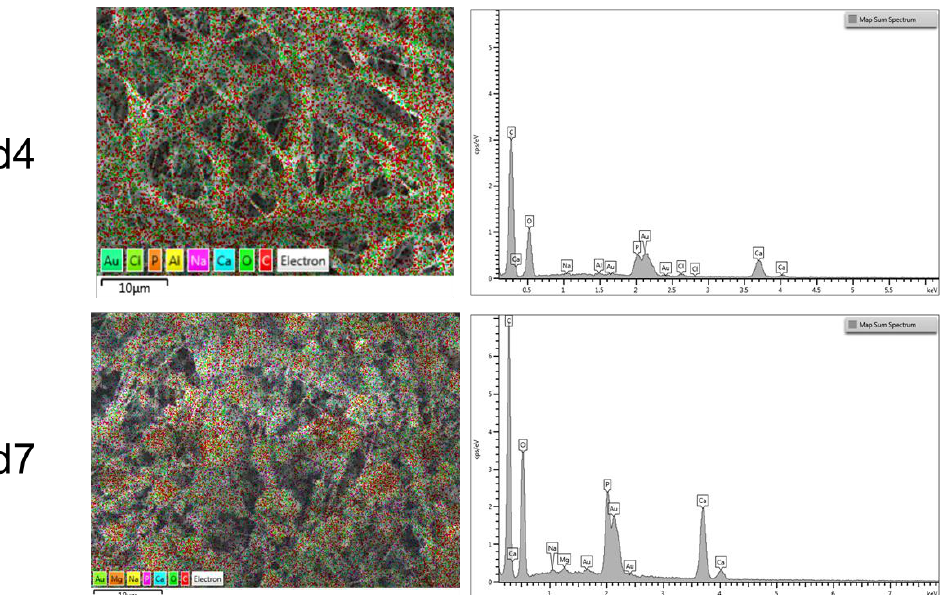
Figure 8. E nergy d ispersive X- r ay (EDX) analysis of PCL-BG composite electrospun mats before Figure 8. Energy dispersive X-ray (EDX) analysis of PCL-BG composite electrospun mats before immersion in SBF solution (PCL-BG d0) in the first row; after one day of immersion in SBF (PCL-BG d1) in the second row; after four days of immersion in SBF (PCL-BG d4); and after seven days of immersion in SBF (PCL-BG